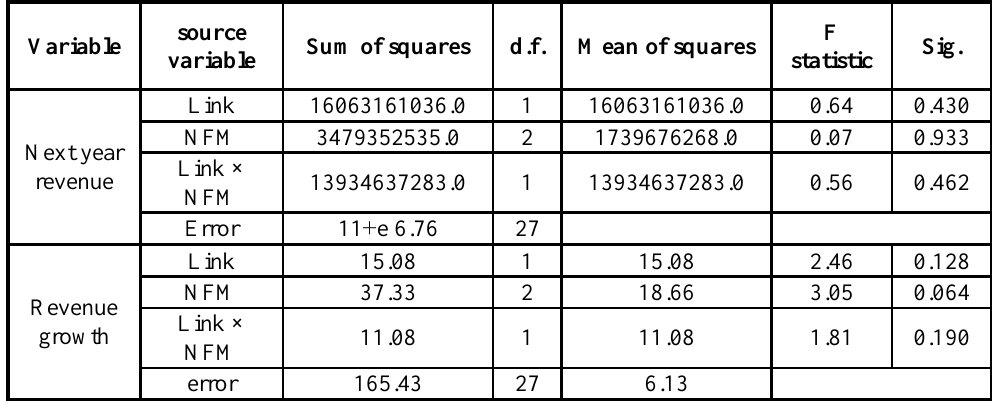
Table 8. two-way ANOVA (non-financial intangible information and causal links for investors with low knowledge)